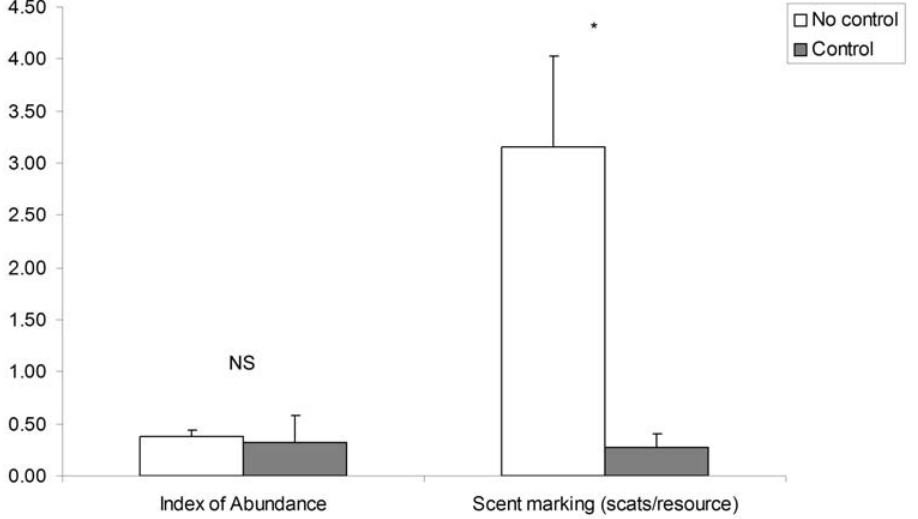
Figure 2. Comparison of abundance and scent-marking between sites with and without dingo control (average + se). doi:10.1371/journal.pone.0006861.g002 PLoS ONE |